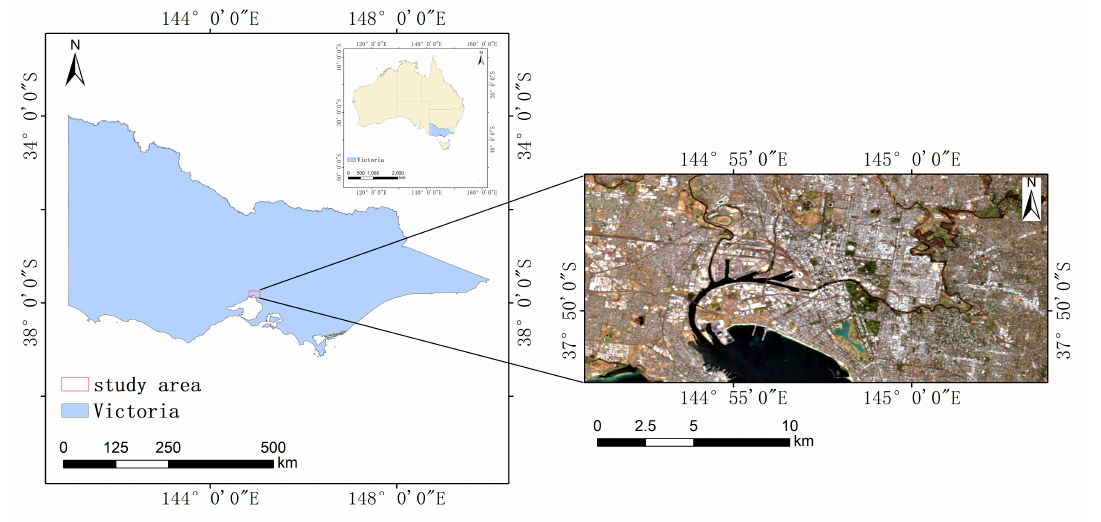
Figure 1. Location of the study area in Melbourne.